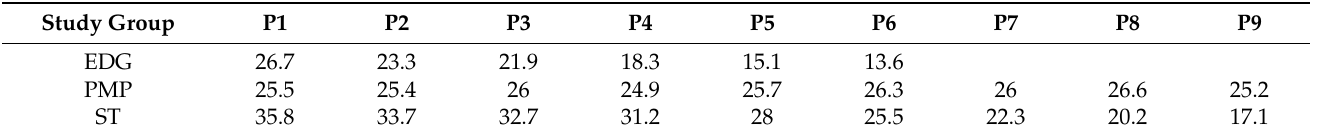
Table 3. Mean helix angle measurements ( ◦ ) at all of the pitches to the tip of novel brands of NiTi alloy endodontic files.